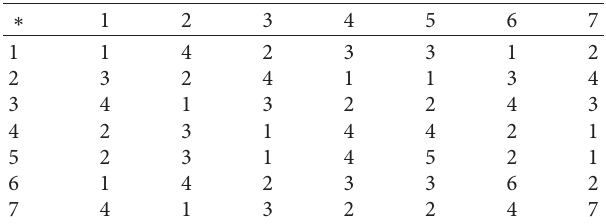
Table 10: Table of Example